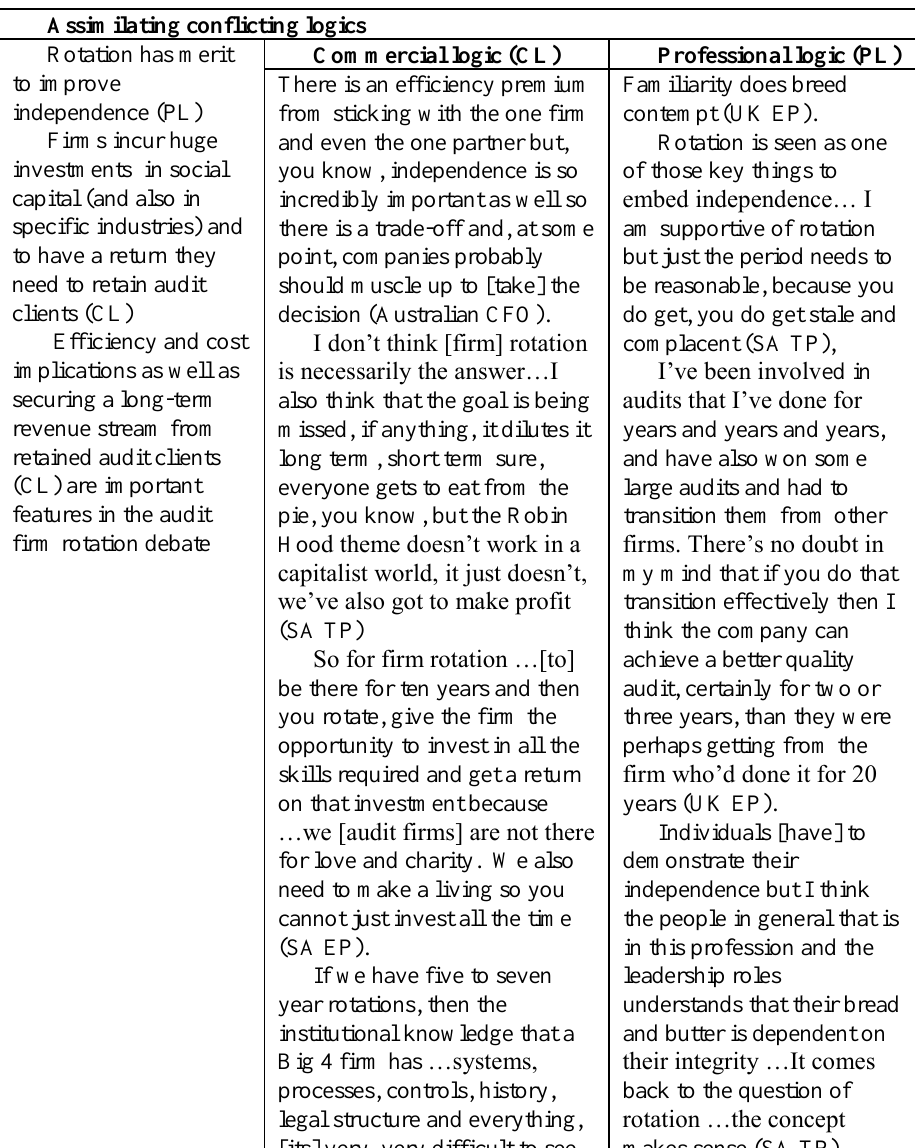
Table 4: Partner/firm rotations: navigating logic multiplicity Assimilating conflicting